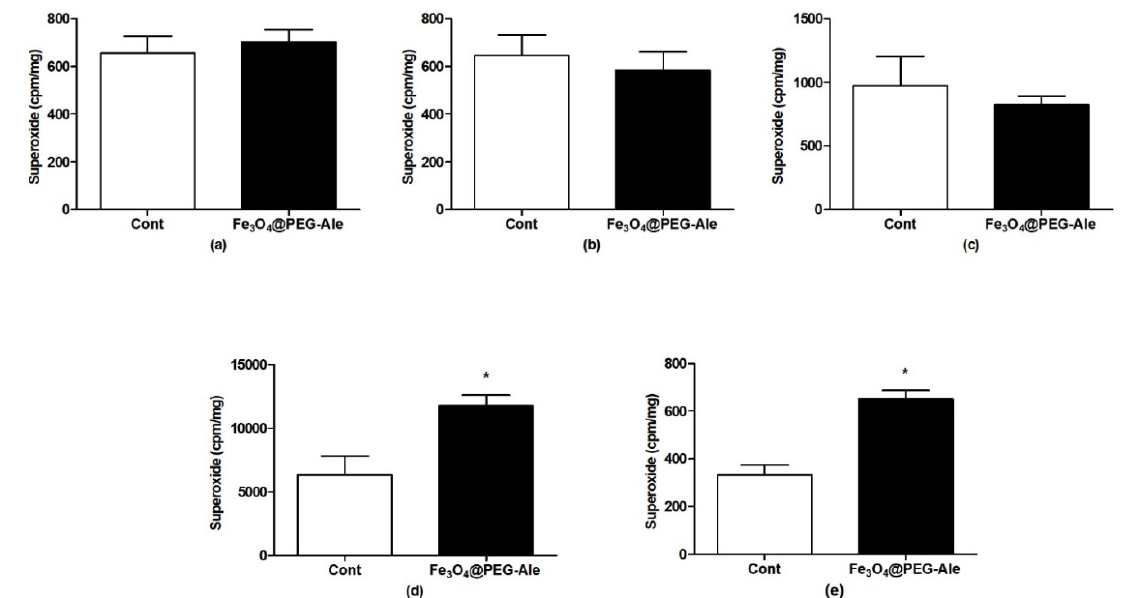
Figure 8. Superoxide production in ( a ) aorta, ( b ) left heart ventricle, ( c ) liver, ( d ) spleen, and ( e ) kidney after IV administration of Fe 3 O 4 @PEG-Ale nanoparticles in rats. The values represent the mean ± SEM * p < 0.05 vs. control group, n = 5–6 per group. Cont, control; Fe 3 O 4 @PEG-Ale, Fe 3 O 4 @PEG-alendronate nanoparticles.